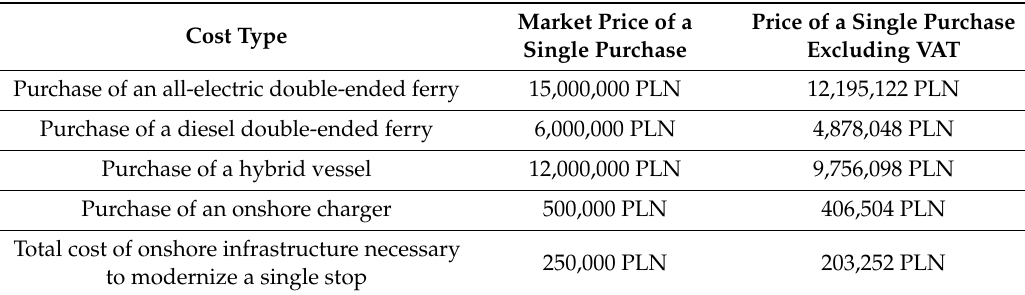
Table 6. Assumed investment costs.